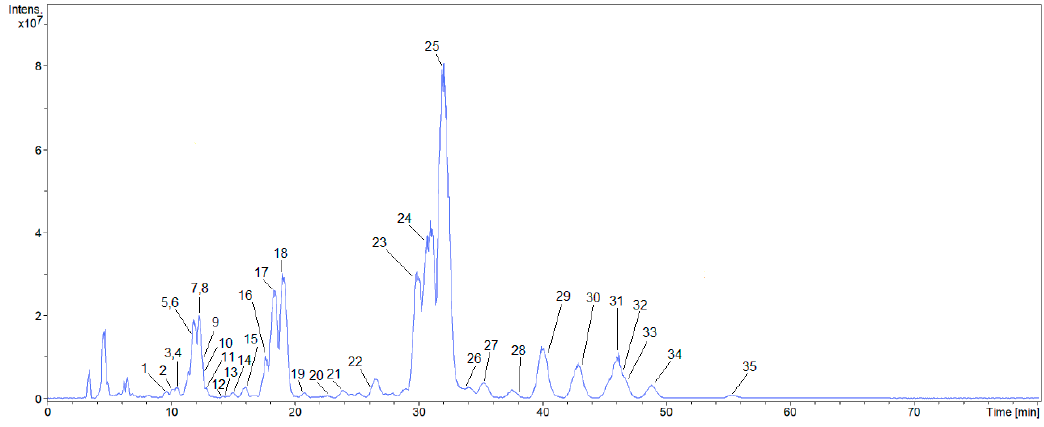
Figure 1. Base peak chromatogram (BPC) of the concentrated fraction of saponins obtained by ESI-MS/MS in negative mode.